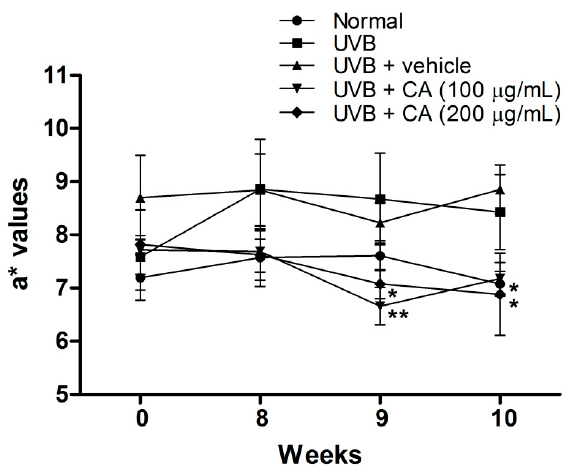
Figure 11. Effects of CAE on a* values in UVB-irradiated hairless mice in the tenth week. Significant difference versus the UVB-induced group: *, p < 0.05, **, p < 0.01.